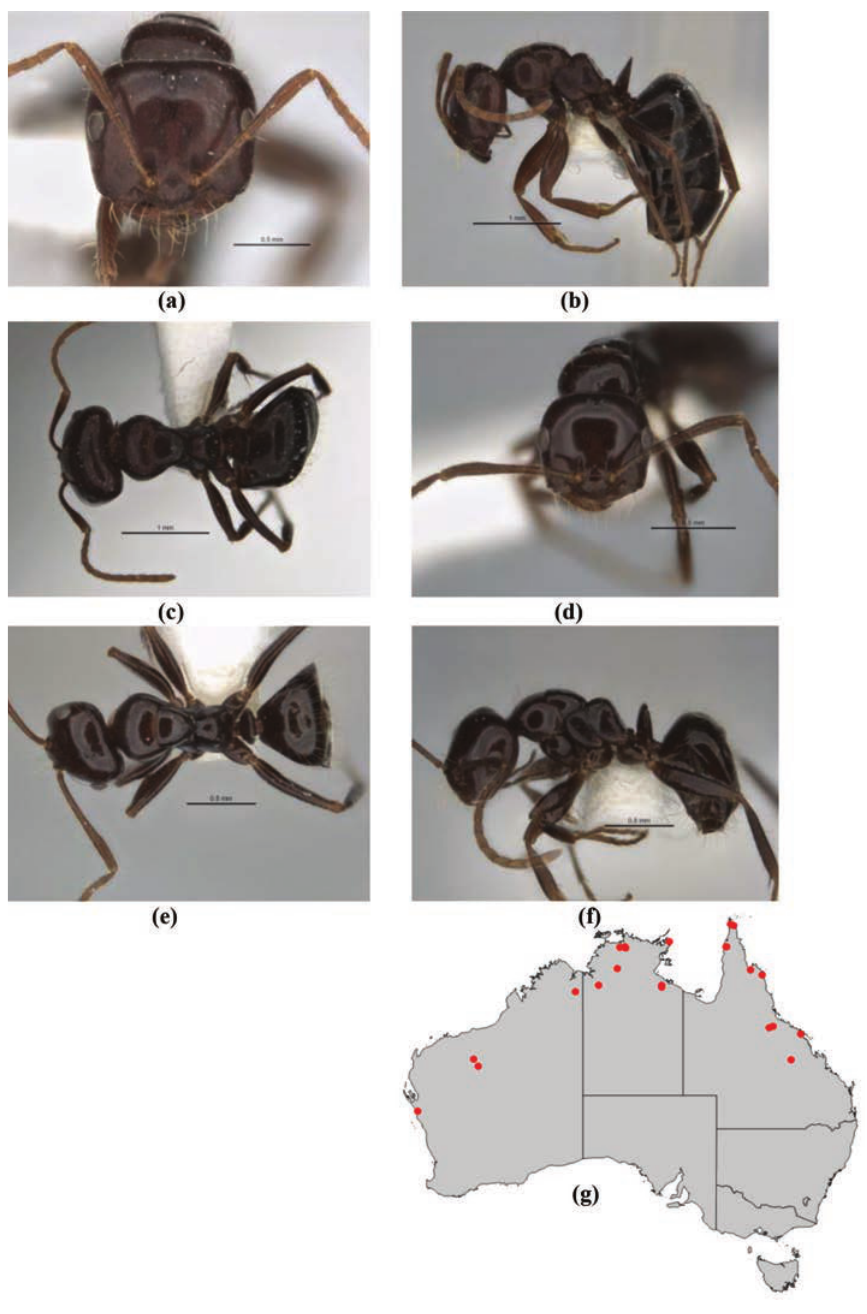
Figure 35. Melophorus dicyrtos sp. n.: major worker paratype (ANIC ANTS VIAL 38.92 [ANIC32- 900177]–top ant) frons ( a ), profile ( b ) and dorsum ( c ); minor worker holotype (ANIC ANTS VIAL 38.92 [ANIC32-900177]–bottom ant) frons ( d ), profile ( e ) and dorsum ( f ); distribution map for the species ( g ). Low resolution scale bars: 1 mm ( b, c ); 0.5 mm ( a, d–f